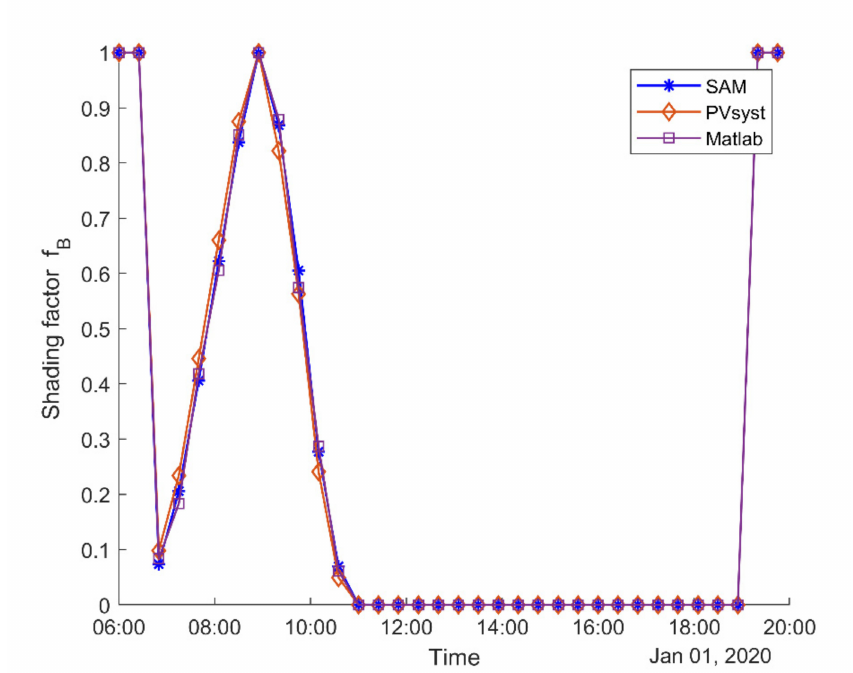
Figure 15. Shading factor f B for situation 1 calculated for one day (1 January). f B was calculated with the System Advisor Model (SAM), PVsyst, and the proposed Matlab tool.